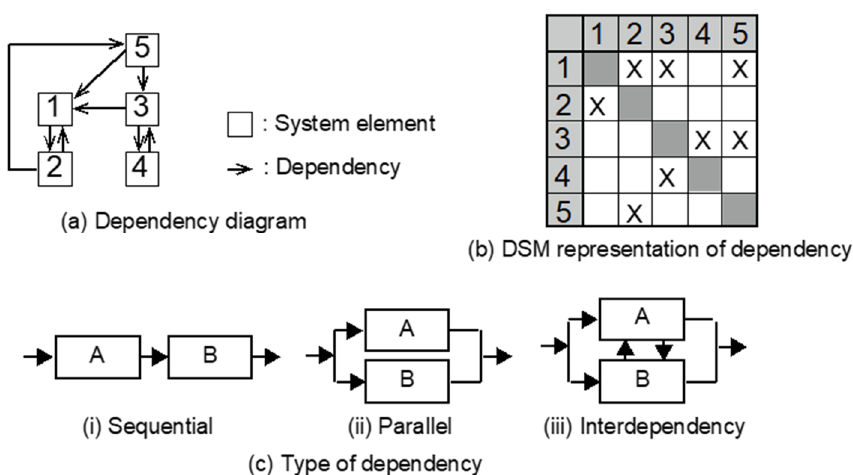
Figure 2. Design structure matrix [19]. ( a ) Dependency diagram; ( b ) DSM representation of dependency; ( c ) type of dependency.